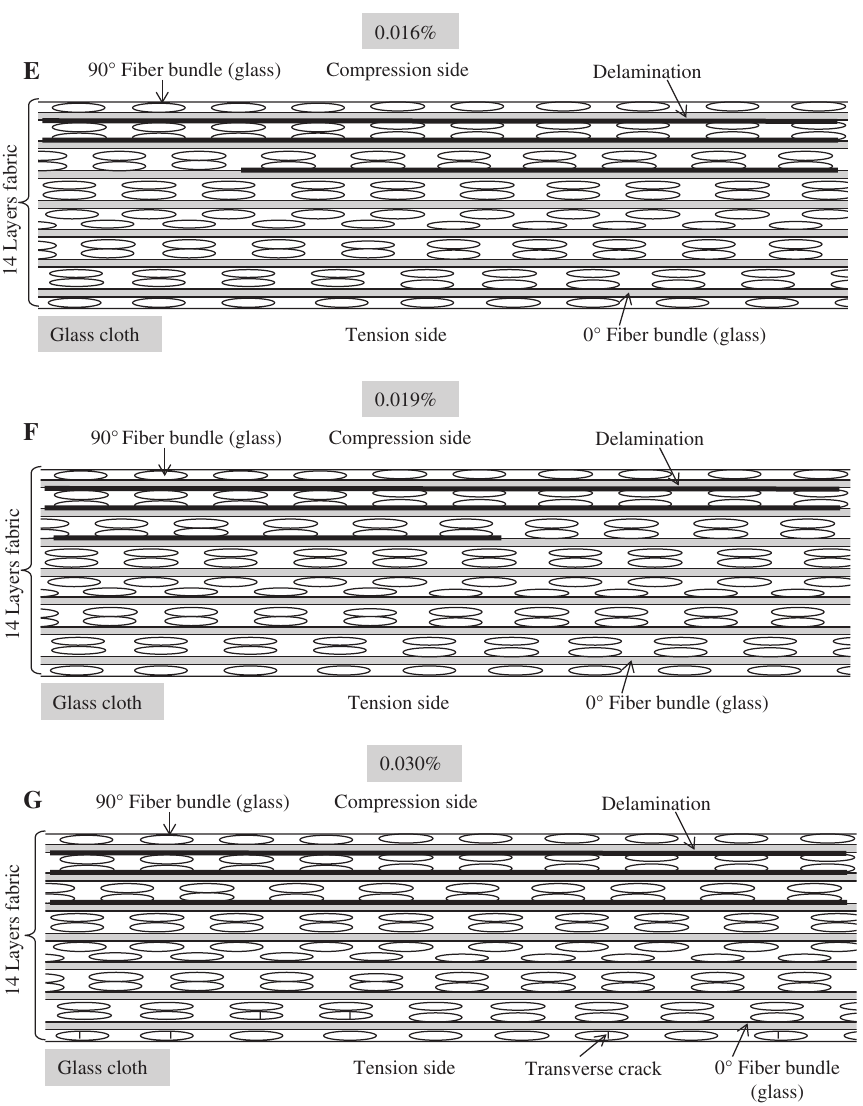
Figure 9 Schematic drawing of specimens with various strains during the three-point bending test: (A–D) glass roving and (E–G) glass